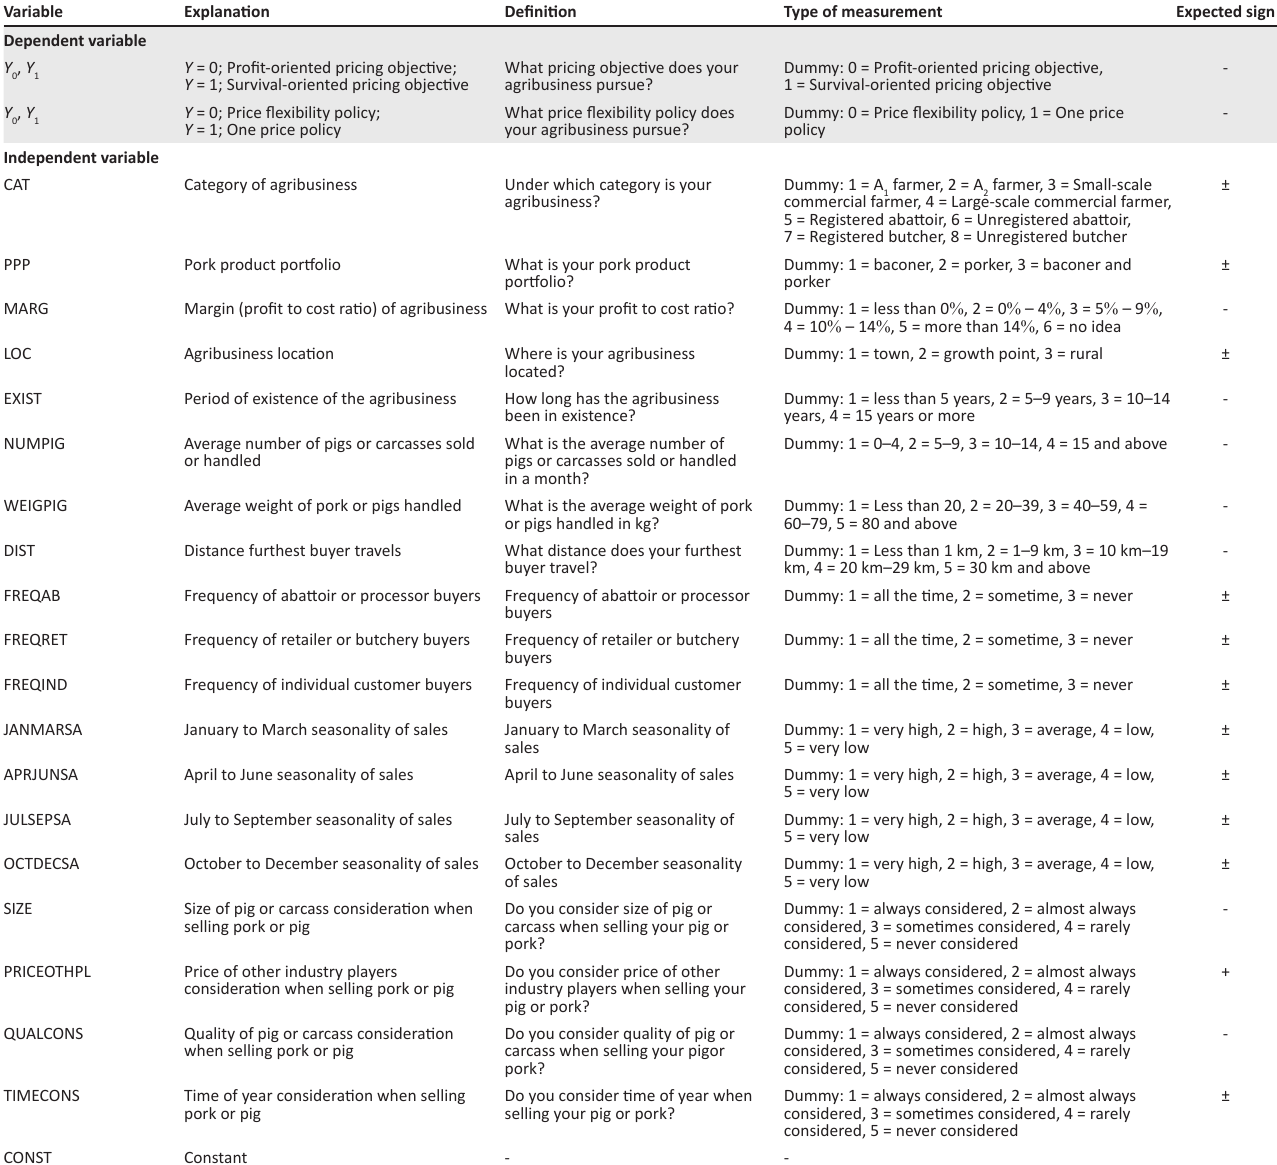
TABLE 2: Variables used in the logistic regression model.